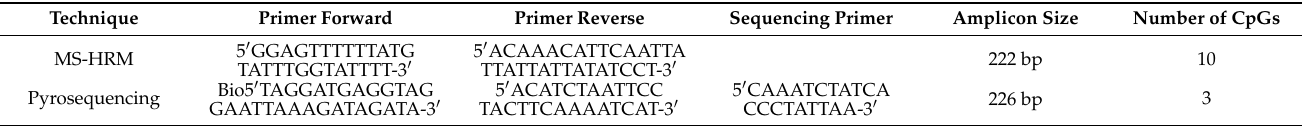
Table 2. Primers sequences, amplicon size, and number of CpGs analyzed to investigate D-loop methylation by means of MS-HRM and